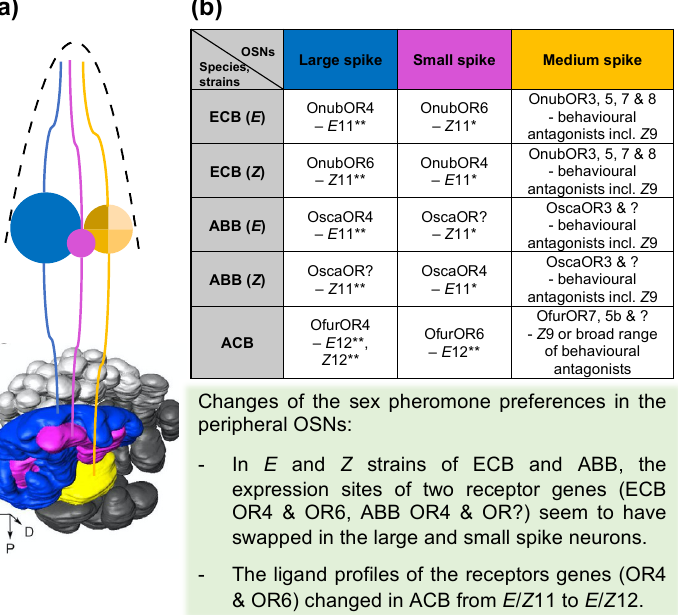
Figure 5. Schematic showing ( a ) the arrangement of peripheral OSNs in the most prevalent type of sensilla trichodea on antennae of male Ostrinia moths and the projection to MGC in the antennal lobe, as well as ( b ) the putative location and ligand profiles of pheromone receptor genes in the OSNs. ** and * indicate the major and minor pheromone components in respective species/strains. The sensillum depicted here corresponds to sensilla trichodea type A in both strains of ECB and ABB, and sensilla trichodea type 1 and type 2 (subtype A–C) in ACB. The layout of the circuit is